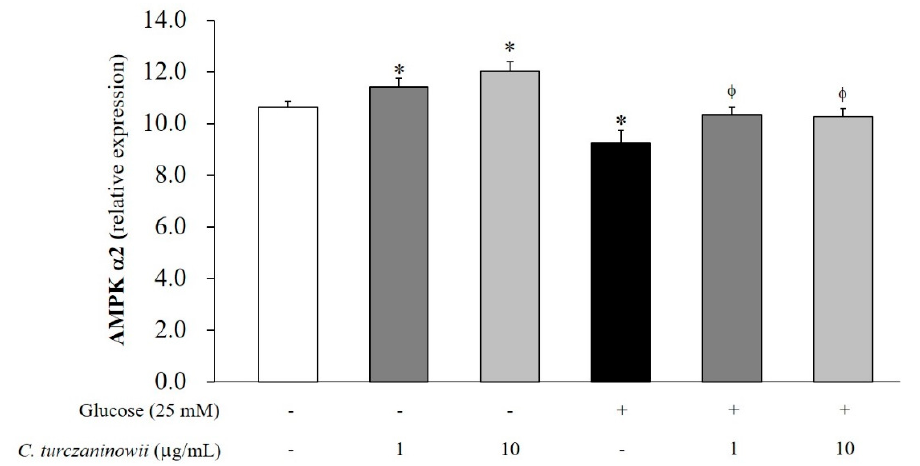
Figure 3. C. turczaninowii extract ameliorates AMP-protein activated kinase α 2 (AMPK α 2) of hASMCs under high glucose conditions in vitro. Data are expressed as mean ± SD. * p < 0.05 relative to non-treated cells, and φ p < 0.05 relative to glucose-stimulated cells. The mRNA levels of AMPK α 2 were measured by reverse transcription PCR. Three wells were used in each condition per experiment, and all the experiments were repeated three times. C. turczaninowii : Carpinus turczaninowii ; hASMCs: human aortic vascular smooth muscle cells; AMPK α 2: adenosine monophosphate (AMP)-protein activated kinase α 2; PCR: polymerase chain reaction.